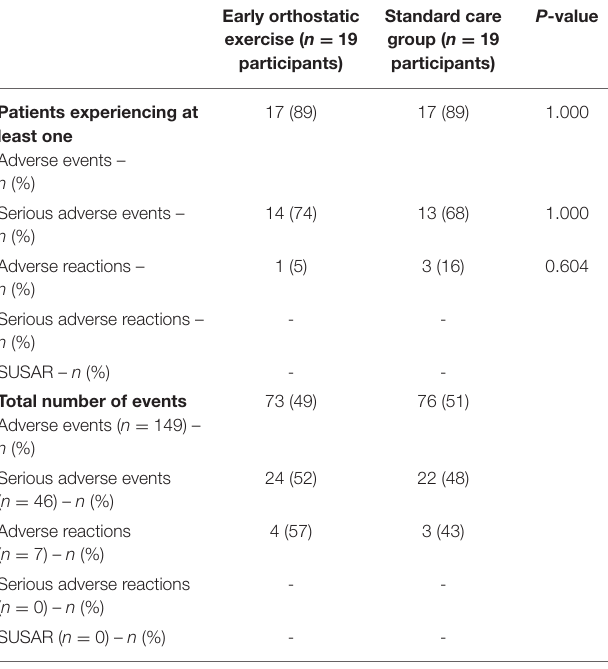
TABLE 3 | Adverse events and reactions during the 4-week intervention period. TABLE 4 | Adverse events and reactions during the 4-week intervention period – Per protocol